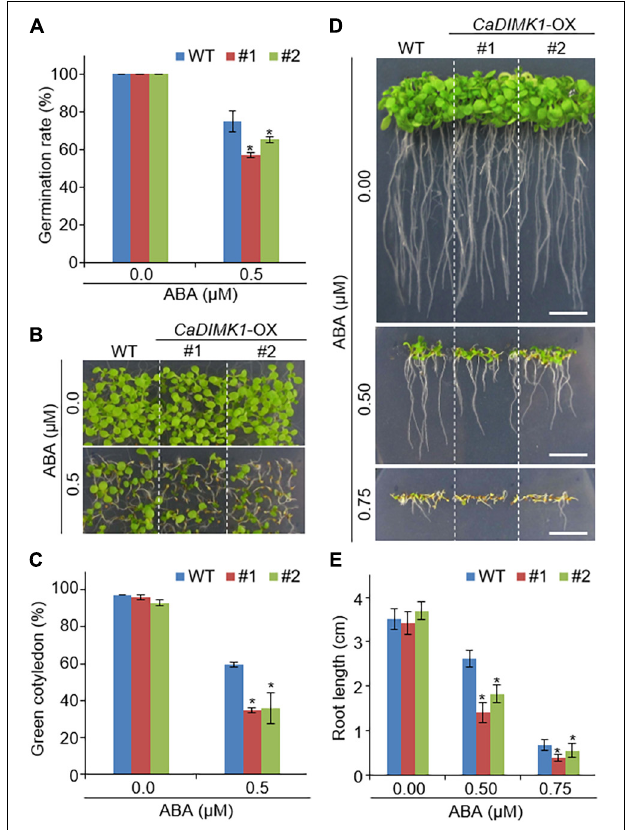
FIGURE 5 | Increased sensitivity of CaDIMK1 -OX plants to ABA. (A) Seed germination rates of transgenic lines and wild-type (WT) Col-0 plants on 0.5 × MS medium without ABA or supplemented with ABA and measured 7 days after sowing. (B,C) Cotyledon greening of CaDIMK1- OX and wild-type plants on 0.5 × MS medium with or without ABA. Five days after plating, representative photographs were taken (B) and cotyledon greening in transgenic and wild-type plants was measured (C) . Values are mean ± SE with six independent experiments ( n = 36). (D,E) Root length of CaDIMK1- OX Arabidopsis and wild-type (WT) plants on 0.5 × MS medium containing 0.0, 0.5, and 0.75 µ M ABA. Seven days after plating, representative photographs were taken (D) and primary root lengths in the transgenic and wild-type plants were measured (E) . The scale bar represents 1 cm. Values are mean ± SE with three independent experiments ( n = 25). Asterisks indicate statistical differences between wild-type and CaDIMK1- OX plants according to Student’s t -test (* P <